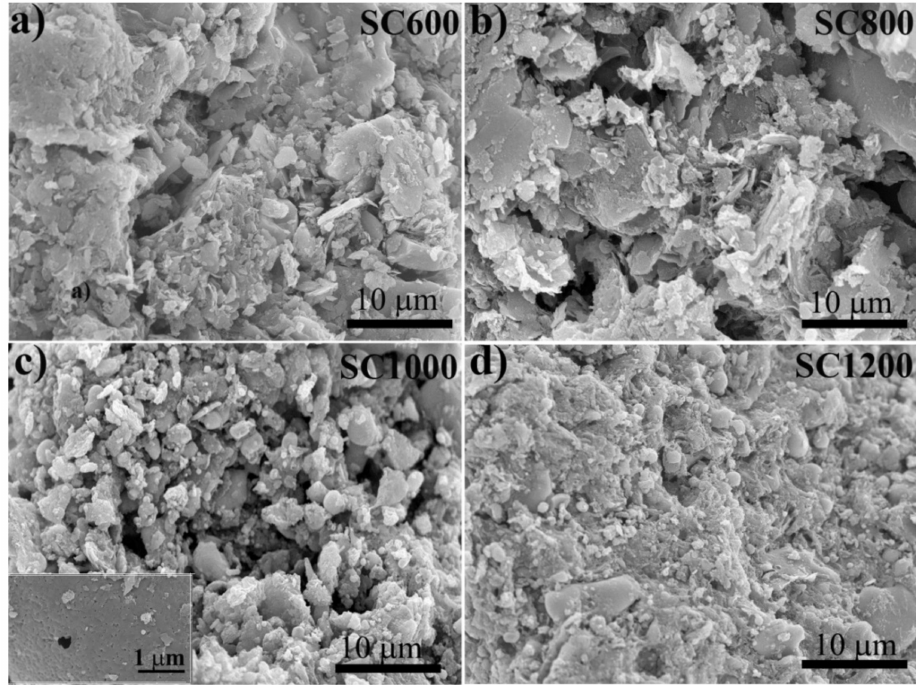
Figure 1. SEM images of SC samples under different carbonization temperature: ( a ) SC600, ( b ) SC800, ( c ) SC1000, and ( d )